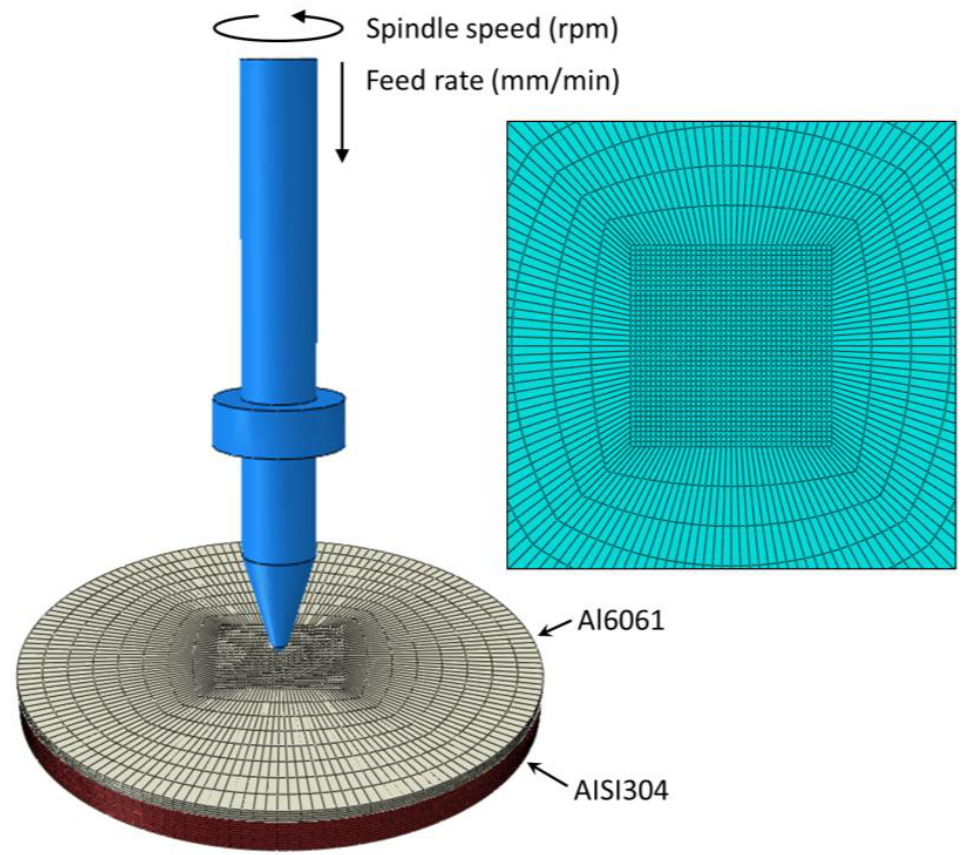
Figure 8. Mesh generated in developed thermo-mechanical finite element model.